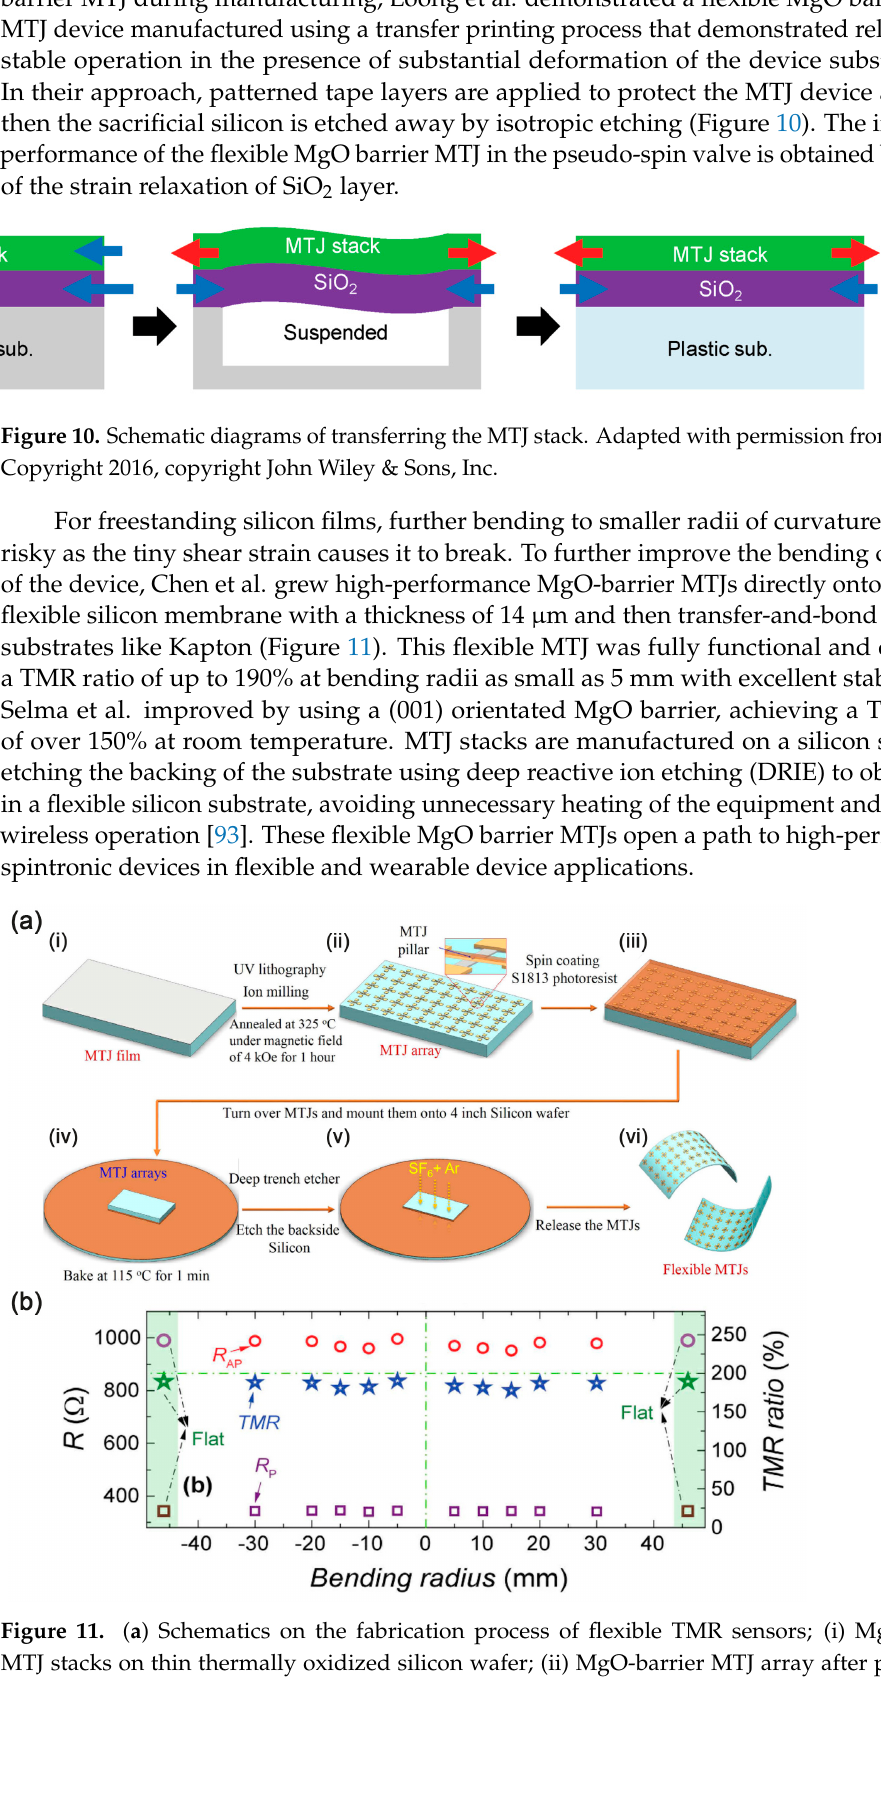
Figure 11. ( a ) Schematics on the fabrication process of flexible TMR sensors; (i) MgO-barrier